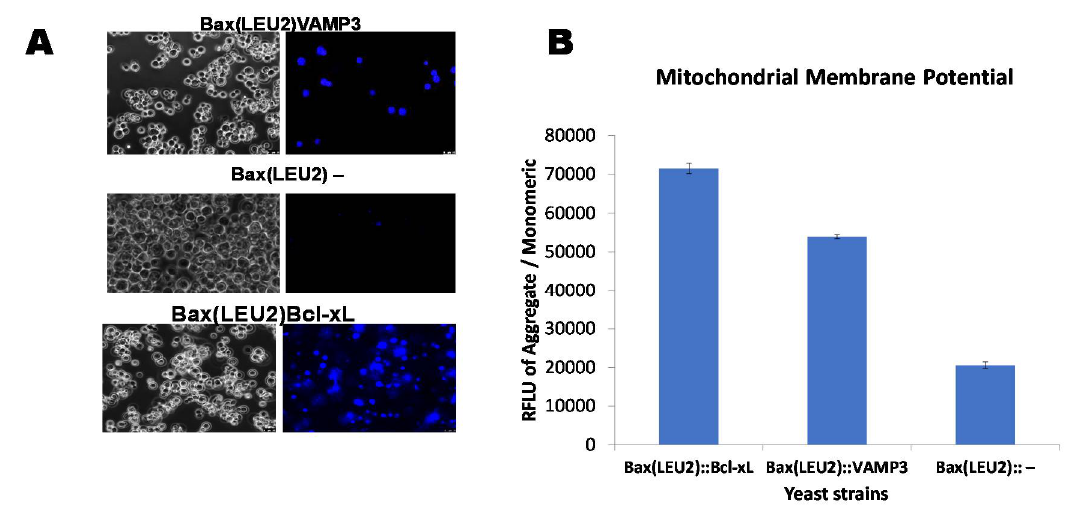
Figure 2. Live assay (Hoechst 33,342 dye) and measurement of the mitochondrial membrane potential. ( A ) Visualisation of yeast cells that coexpress Bax and VAMP3 and Bcl-xL or Bax alone, after staining with Hoechst 33,342 dye. The images on the left are representative of cells under fluorescent light, showing live cells (blue). ( B ) Quantification of the mitochondrial membrane potential of yeast strains, Bax(LEU2)VAMP3, which coexpressed Bax and VAMP3, Bax(LEU2)Bcl xL, which coexpressed Bax and Bcl xL, and Bax(LEU2), which expresses Bax alone, using a fluorescent plate reader. A two way ANOVA test shows that there was a significant difference ( p < 0.05) between the control strain and each of Bax + VAMP3 and Bax + Bcl-xL, but there was a significant difference ( p < 0.05) between Bax + VAMP3 and Bax + Bcl-xL. The data represent the mean ± S.D. of three independent experiments. RFLU—Relative Fluorescence Unit.